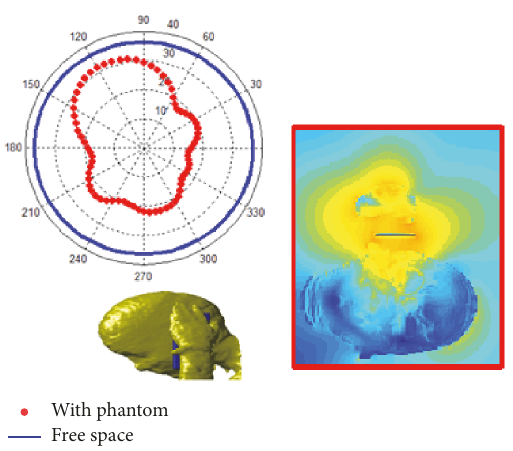
Figure 5: Effects of the head on the radiation pattern of the mobile phone at 900 MHz.